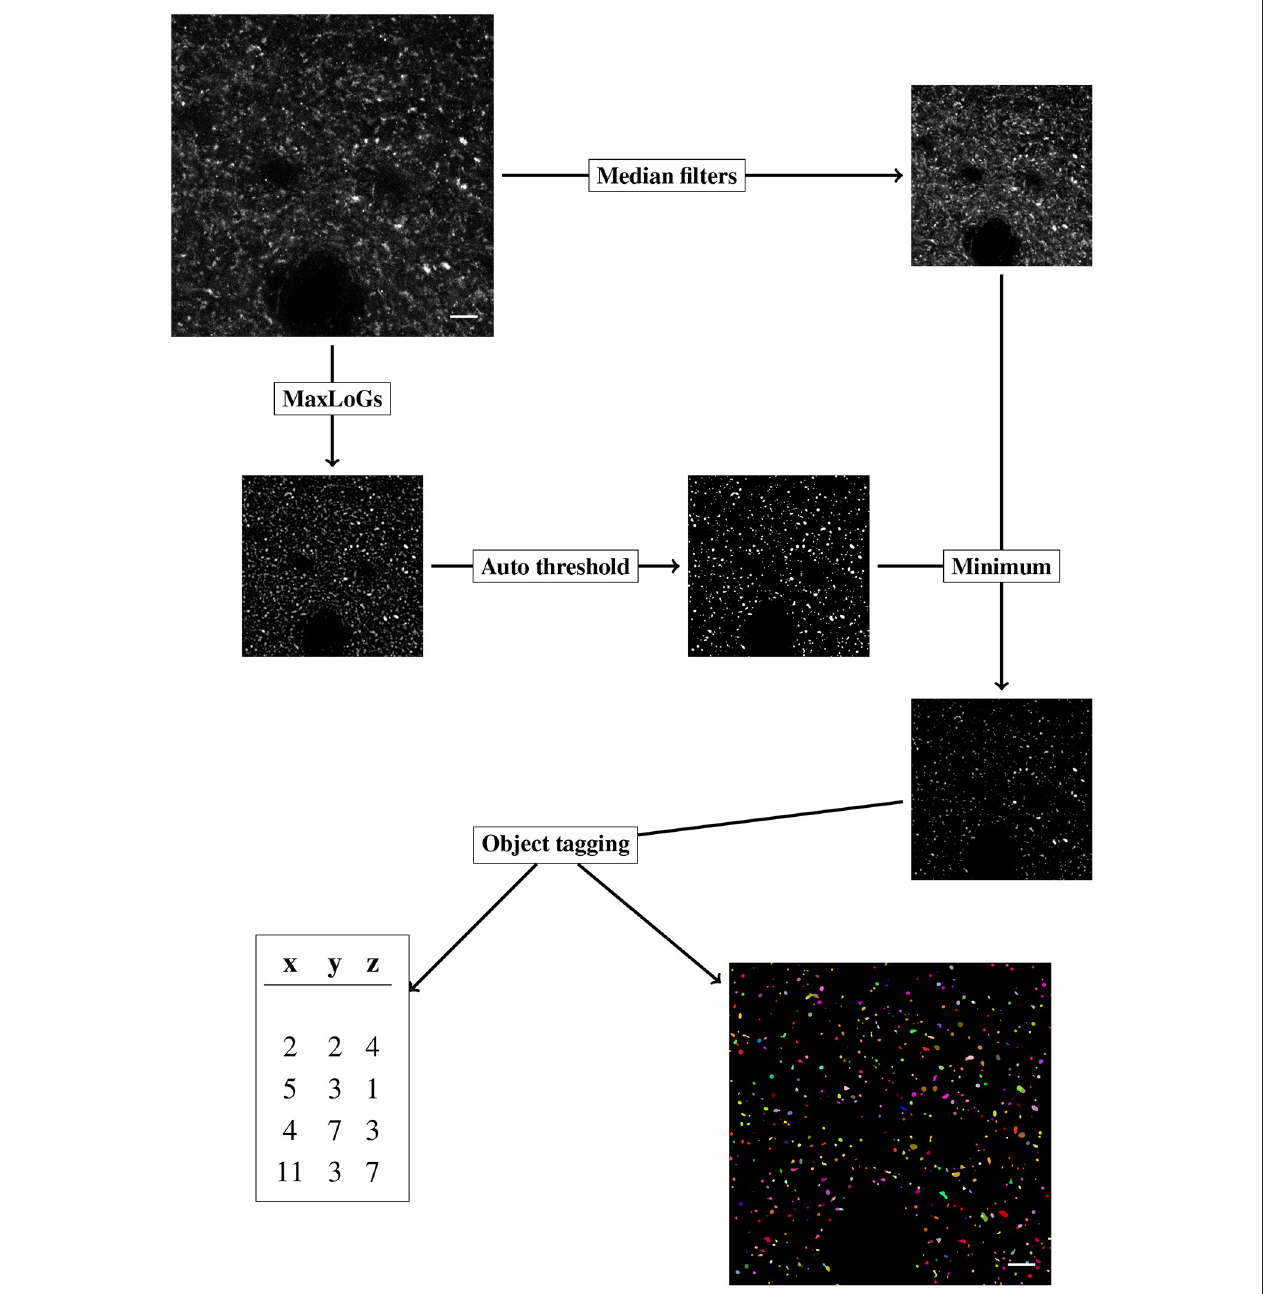
FIGURE 3 | Diagram of the objects detection workflow, the steps of the algorithms are labeled in rectangular boxes. Scale bar is 5 µ m and pixel intensity is enhanced for visualization.